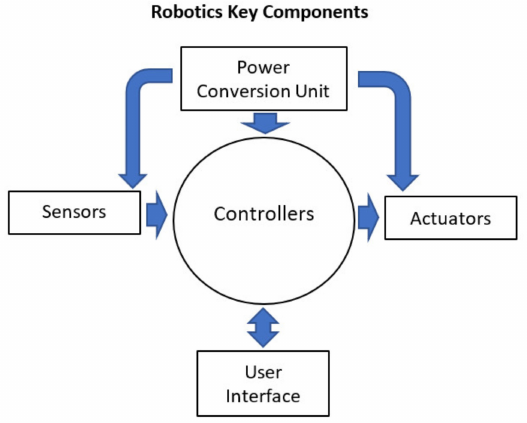
Figure 4. Key components of a robot. The figure shows the components used by robots to fulfill their purposes, such as interaction with their environment